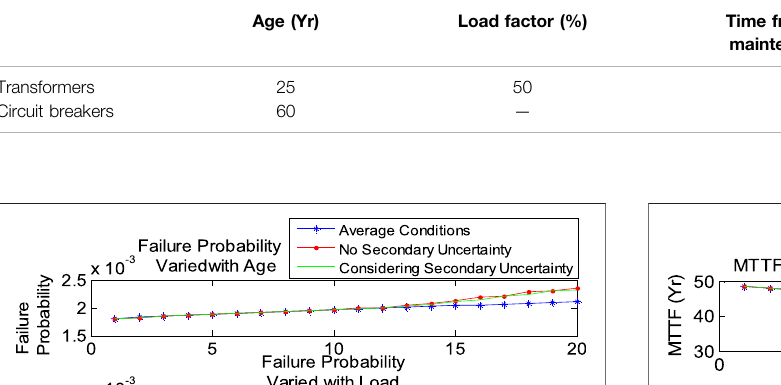
TABLE 3 | Average conditions.